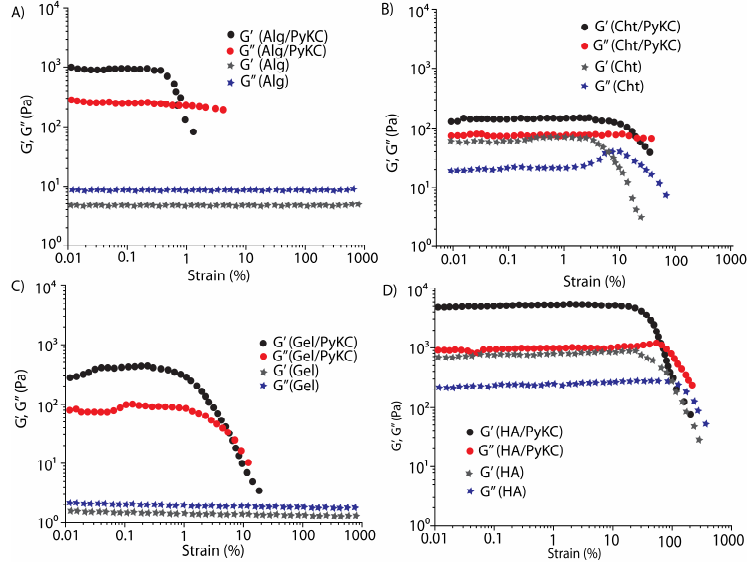
Figure 2. Changes in storage and loss moduli as a function of shear strain (amplitude sweep at a frequency of 1 rad·s −1 ) for ( A ) Alg and Alg/PyKC, ( B ) Cht and Cht/PyKC, ( C ) Gel and Gel/PyKC, and ( D ) HA and HA/PyKC hydrogels measured at room temperature.